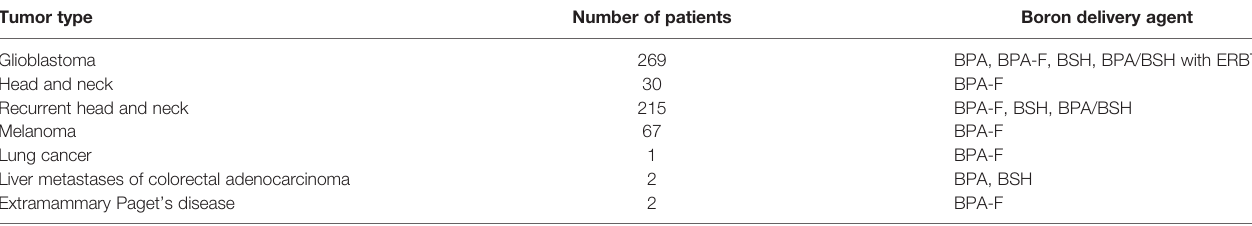
TABLE 1 | Clinical trials of different boron delivery